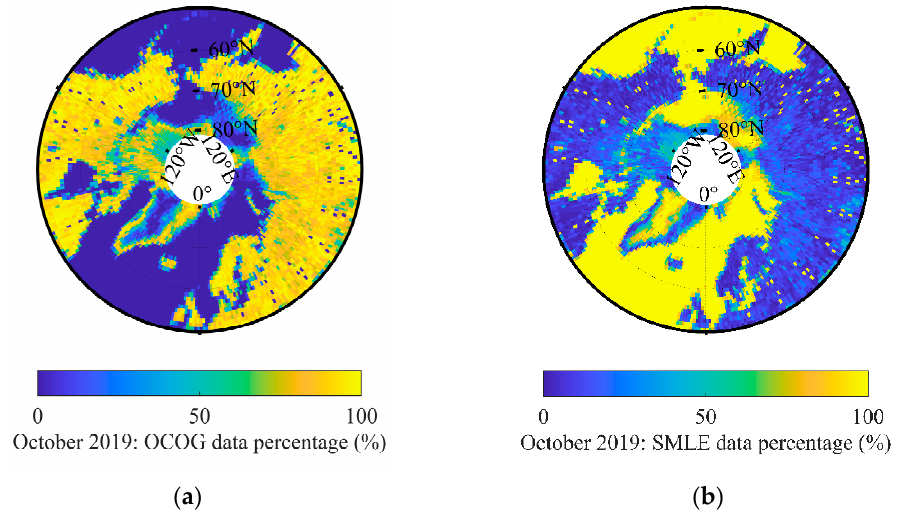
Figure 1. The percentage of OCOG and SMLE tracking model data: ( a ) OCOG; ( b ) SMLE.